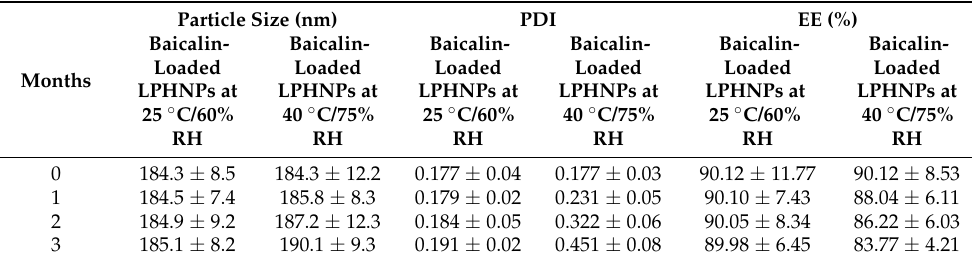
Table 1. Stability studies of baicalin-loaded LPHNPs following storage at 25 ◦ C/60% RH and 40 ◦ C/75% RH.